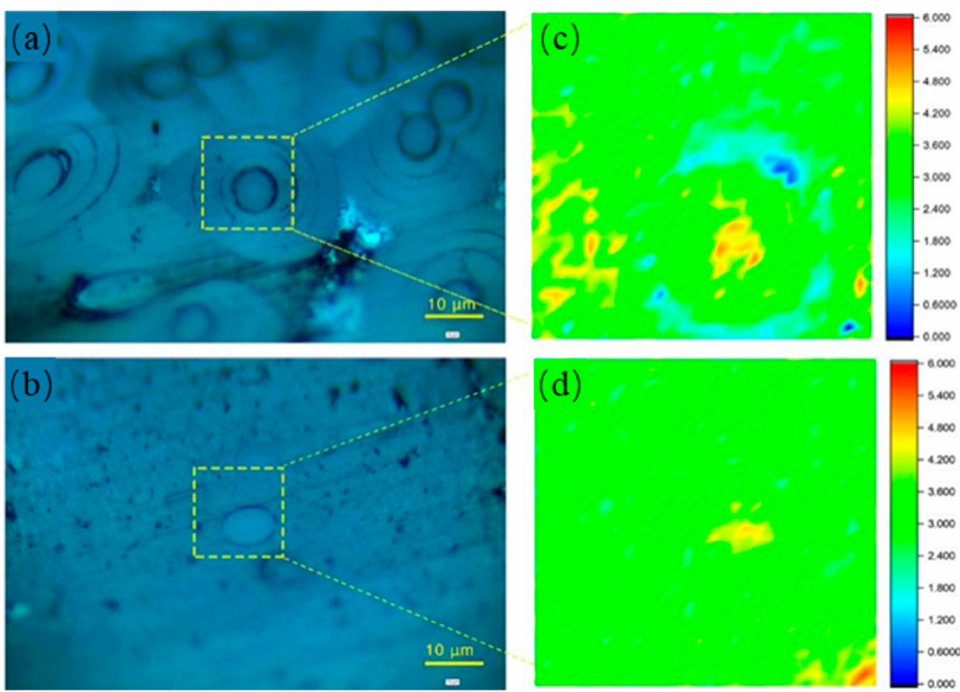
Figure 6. Raman spectra analysis after thermal shock test of ( a , c ) C/C and ( b , d ) CC/C composites: ( a , b ) Optical micrographs; Raman mapping of the shift in G peak, reflecting the stress distribution in carbon fiber.